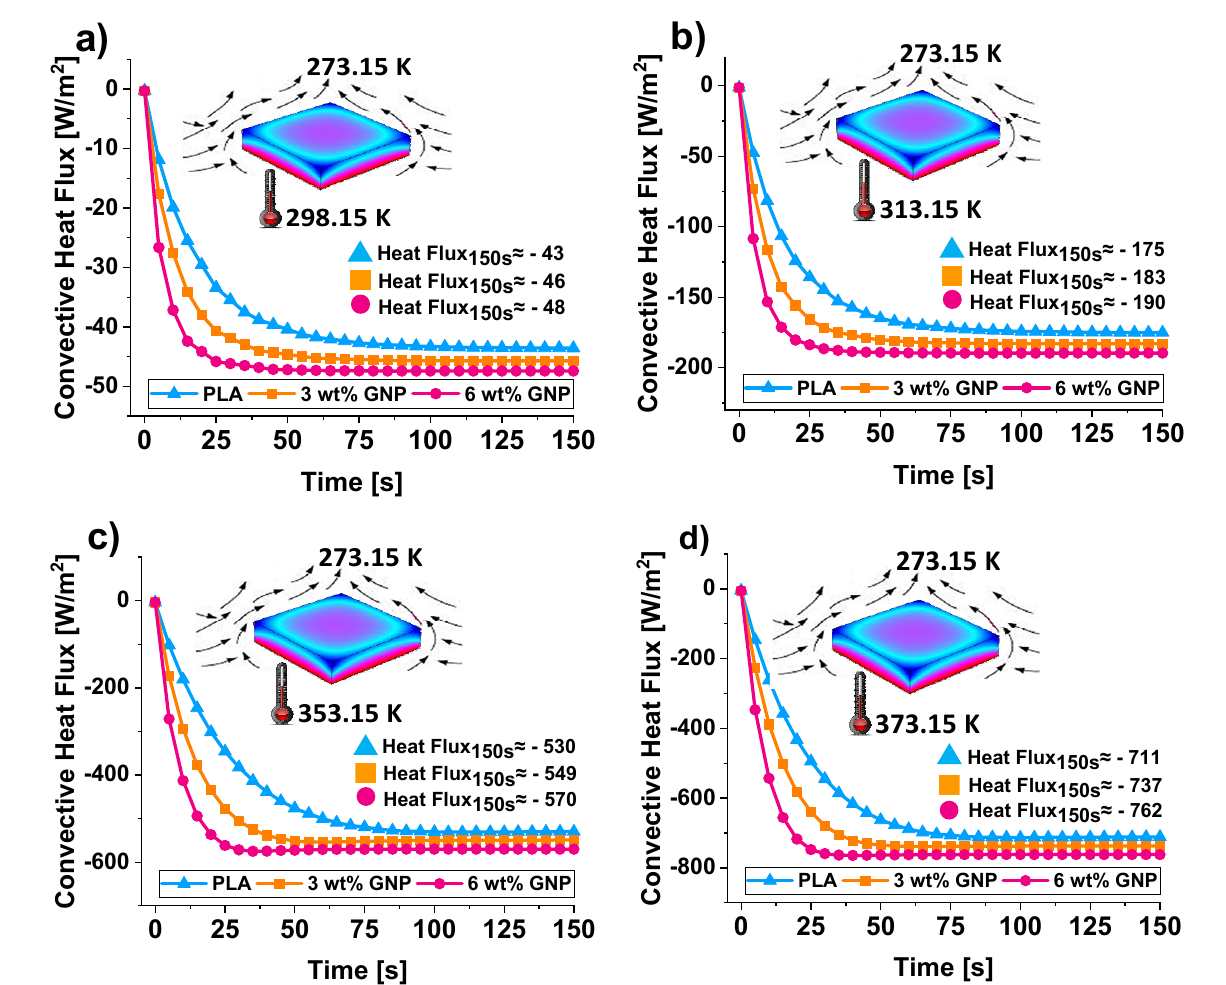
Figure 12. Convective heat flux trends over time for the three polymer-based heat exchanges operating at different temperature values: 298.15, 313.15, 353.15, and 373.15 K in ( a – d ), respectively. A 3D view of the conductive heat flux at steady-state condition ( t = 150 s) and at a temperature value of 373.15 K relatively to PLA, PLA/3 wt% GNPs, and PLA/6